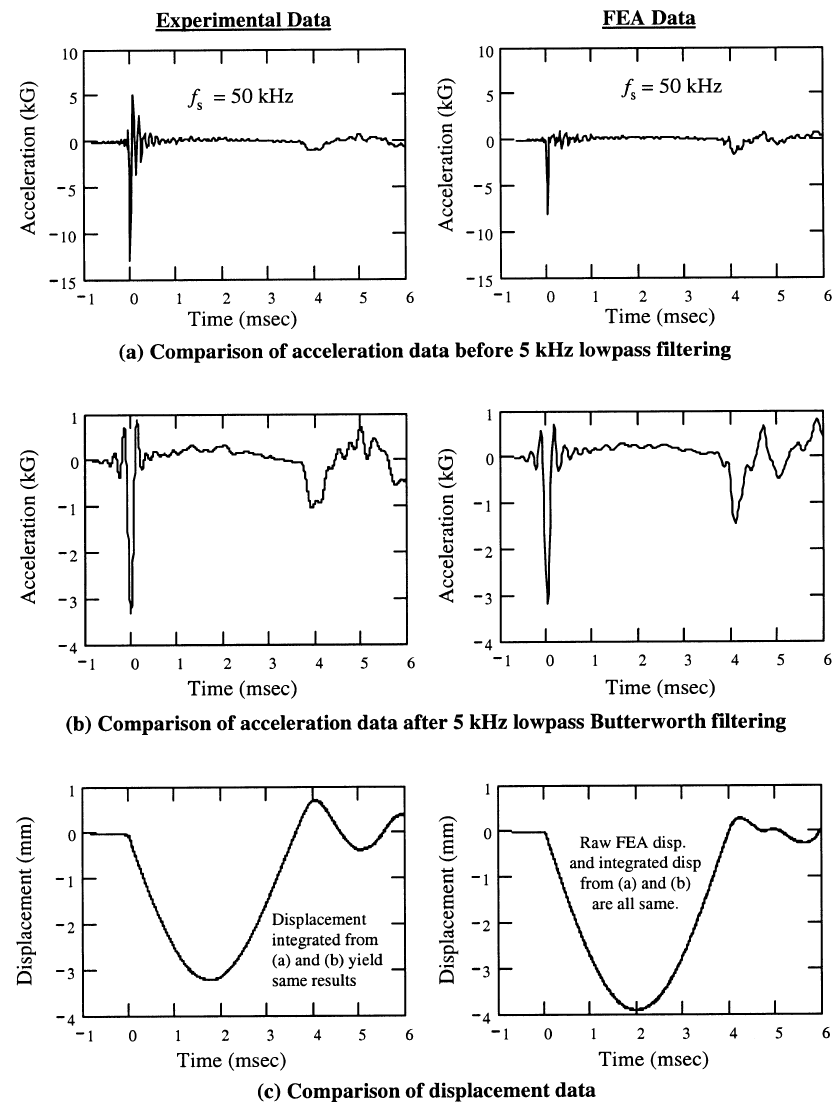
Fig. 5. Processing data with antialias filtering. FEA data is properly decimated down to a 50 kHz sample